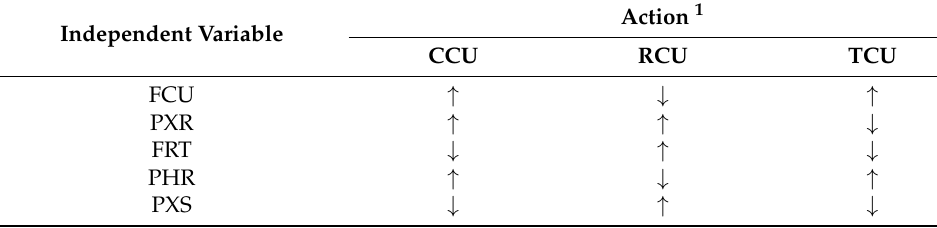
Table 6. Interdependence matrix of parameters in the flotation process. Independent Variable